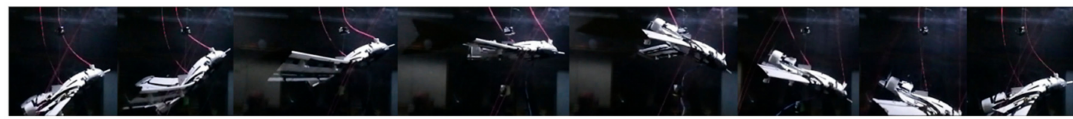
Figure 16. Time-domain acceleration signal and frequency spectrum of wind tunnel test.